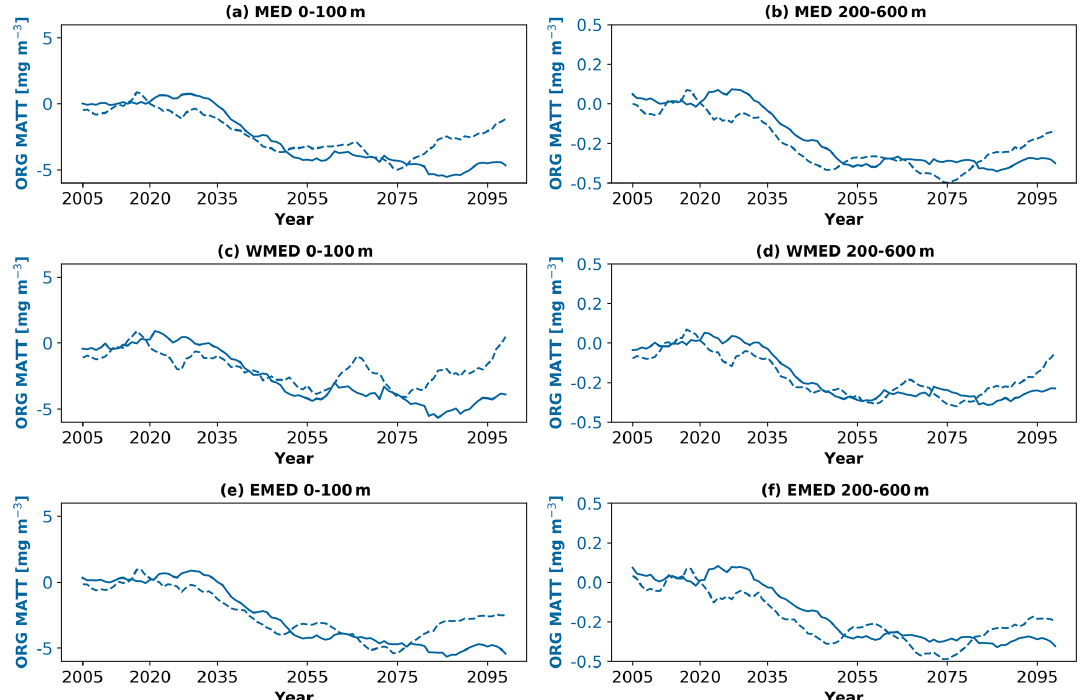
Figure 12. Yearly time series for the period 2005–2099 of living/nonliving carbon organic matter (in mgm − 3 ) anomalies for the emission scenarios RCP8.5 (solid lines) and RCP4.5 (dashed lines) in the Mediterranean Sea (MED, a–b ), Western Mediterranean (WMED, c–d ) and Eastern Mediterranean (EMED, e–f ) for the 0–100m (a, c, e) and 200–600m (b, d, f) layers for the 2005–2099 period. The yearly time series have been smoothed using the 10-year running